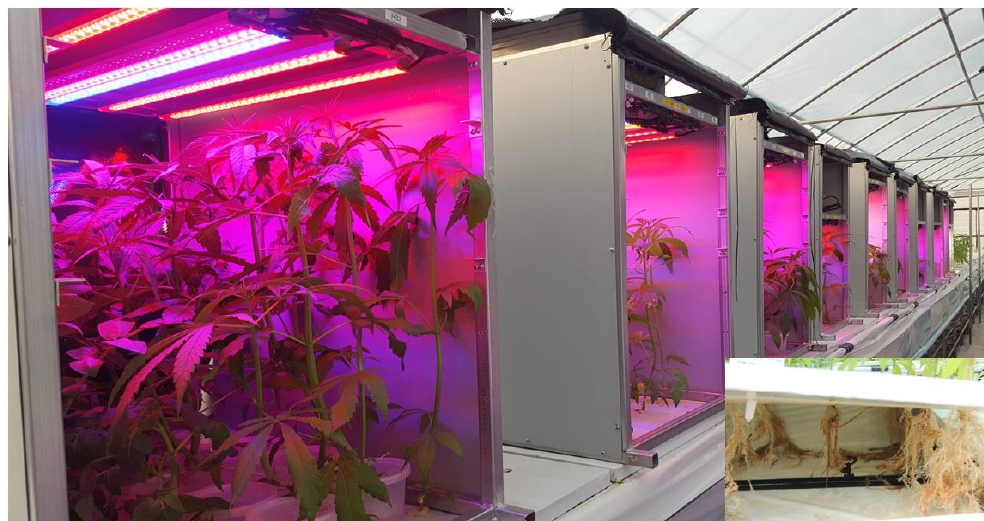
Figure 1. Hemp plants under treatment in the steel-made chambers (80 cm × 60 cm × 80 cm) equipped with different LED lights. Here and subsequent models: L1, Natural light; L2, W; L3, R 8 :B 2 ; L4, R 7 :B 2 :G 1 ; L5, R 7 :B 2 :FR 1 ; L6, R 6 :B 2 :G 1 :FR 1 ; L7, R 5 :B 2 :W 2 :FR 1 ; L8, R 5 :B 2 :G 1 :FR 1 :UV 1 ; L9, R 6 :B 2 :FR 1 :UV 1 ; L10, R 4 :B 2 :W 2 :FR 1 :UV 1 ; L11, R 2 :B 2 :G 2 :W 2 :FR 1 :UV 1 . All treatments used a photosynthetic photon flux density of 300 µmol m −2 s −1 . Insert: The root architecture of the hemp under the aeroponics system. Table 1. LED light composition .